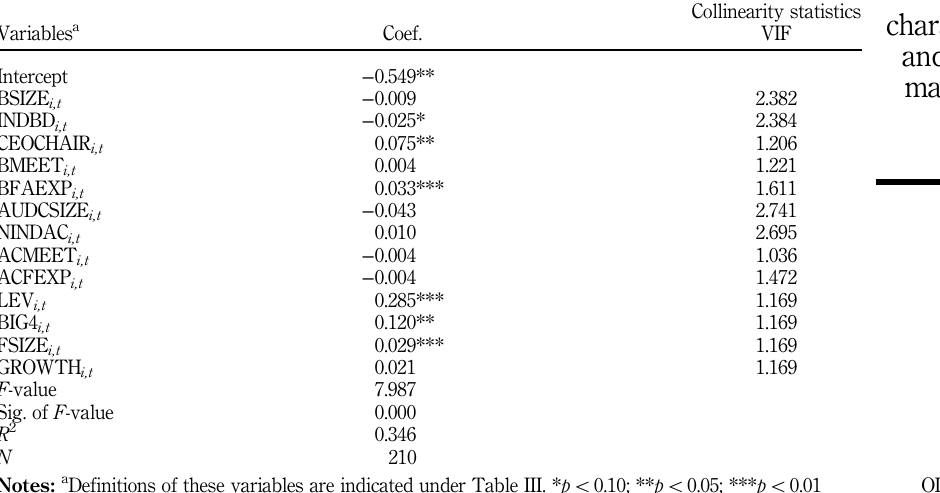
Table VI. OLS multivariate regression